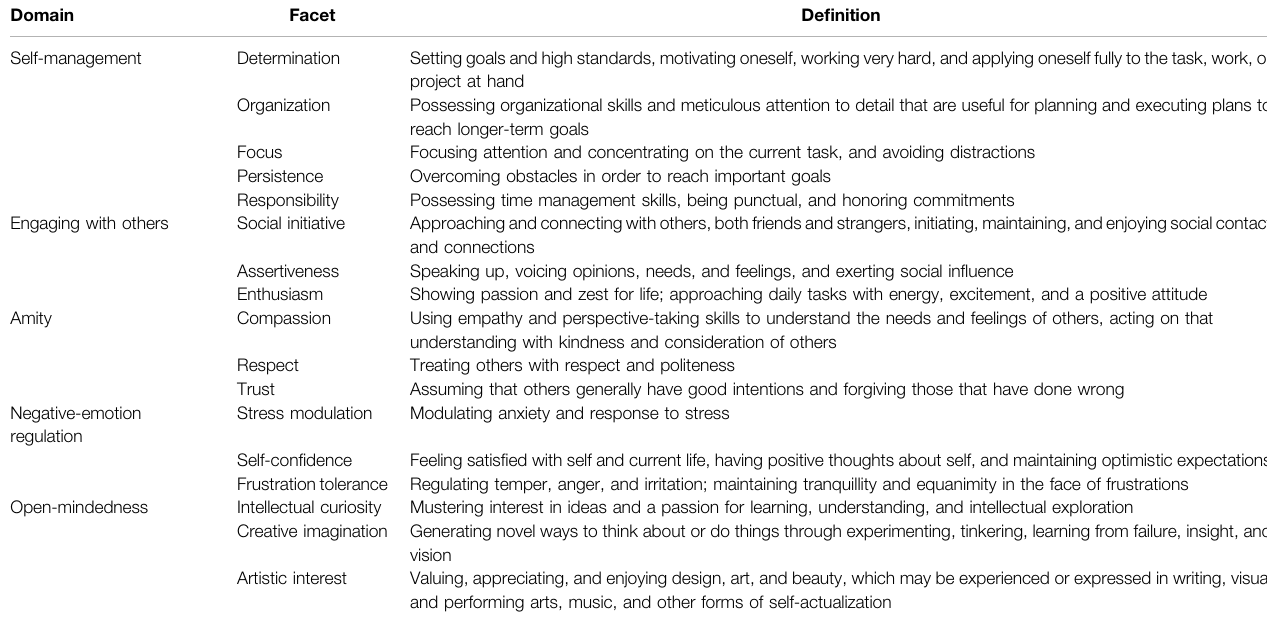
TABLE 1 | Social-emotional skill domains and facets Primi et al. (2017).